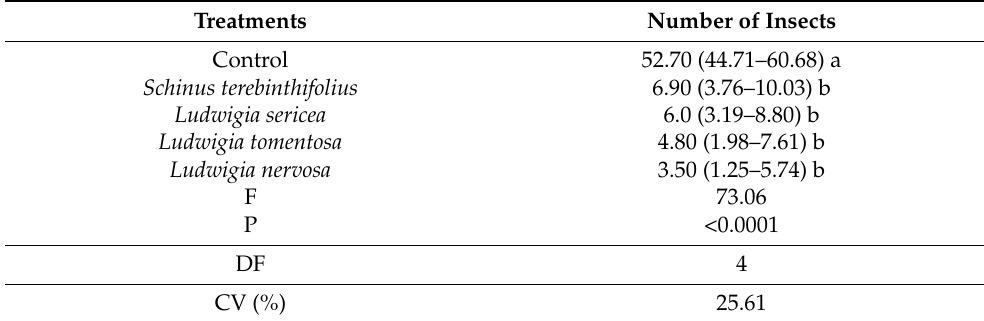
Table 1. Repellency test of four plant extracts ( Schinus terebinthifolius , Ludwigia sericea , Ludwigia tomentosa , Ludwigia nervosa ) and a control (water) on Sitophilus zeamais . Dourados, 2021.